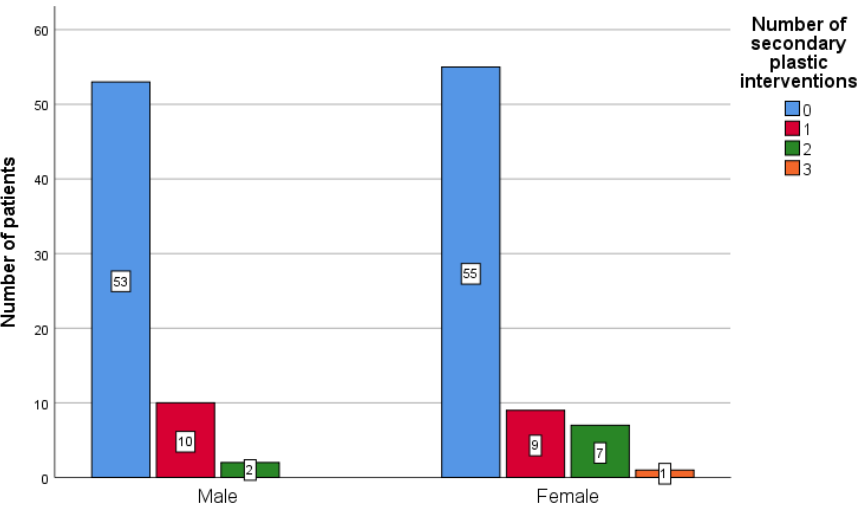
Figure 5. Frequency of secondary palatal surgical interventions based on the sex of the operated